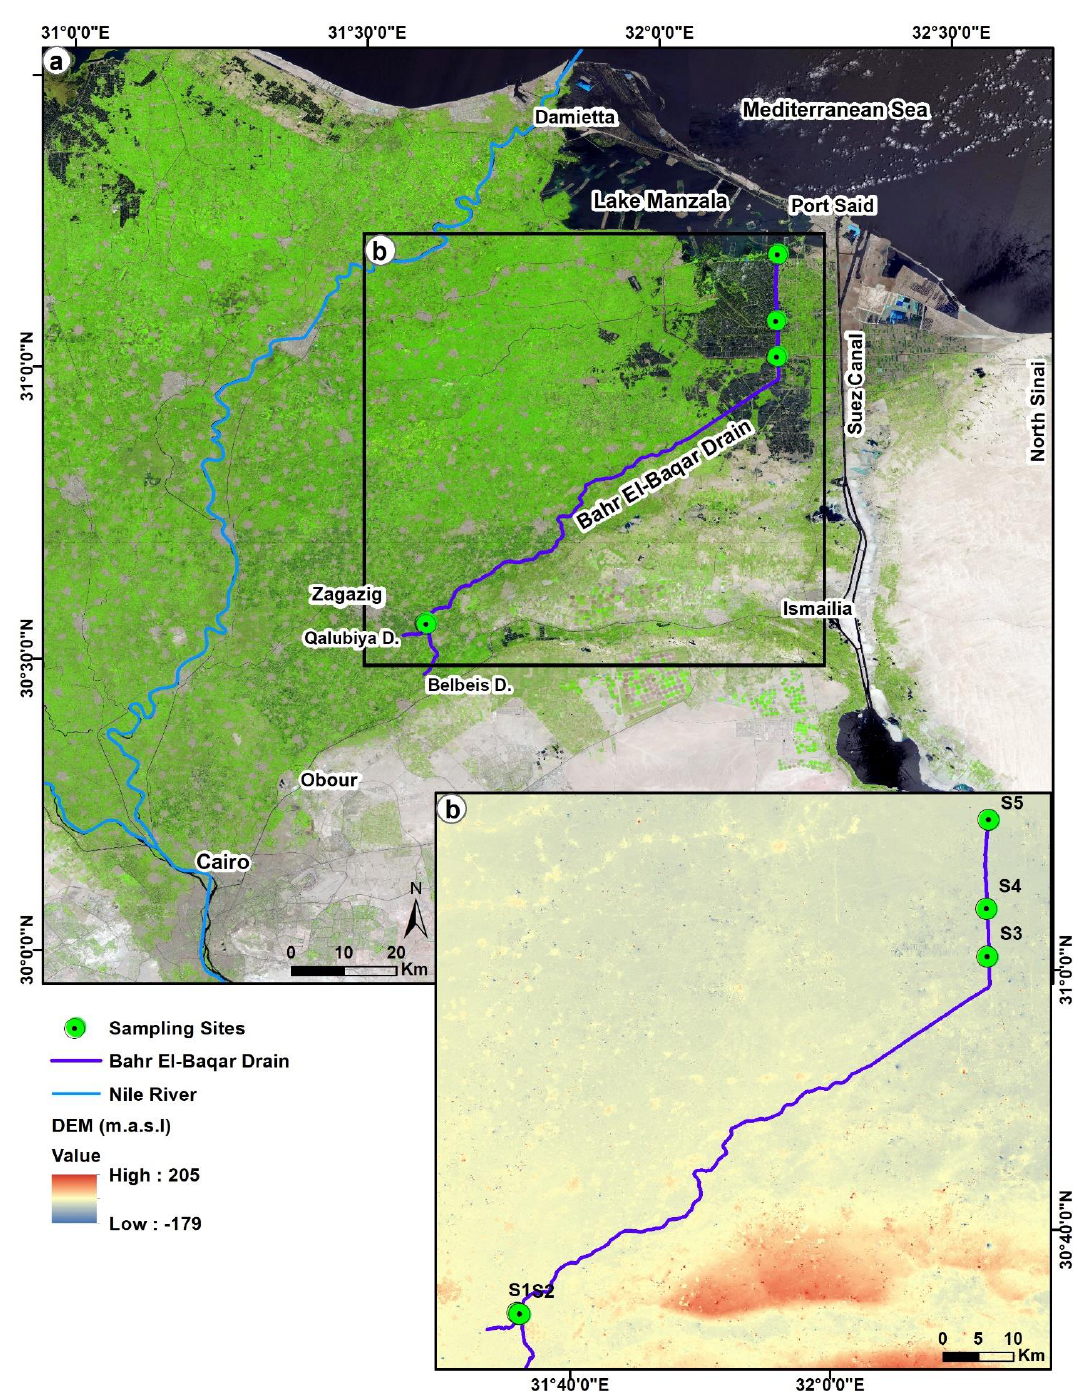
Figure 1. Location map for the study area and sampling sites (S1 − 5) draped over a high − resolution Sentinel − 2A satellite image ( a ) and Advanced Land Observing Satellite (ALOS) Phased Array type L-band Synthetic Aperture Radar (PALSAR) digital elevation model (DEM) ( b ) displaying the elevation buffering zone of Bahr El-Baqar drain, Eastern Nile Delta, Egypt. Belbeis and Qalubiya secondary drains meet in the south at Zagazig, Sharqia Governorate, to form Bahr El-Baqar drain, which flows north to Lake Manzala, south of Port Said